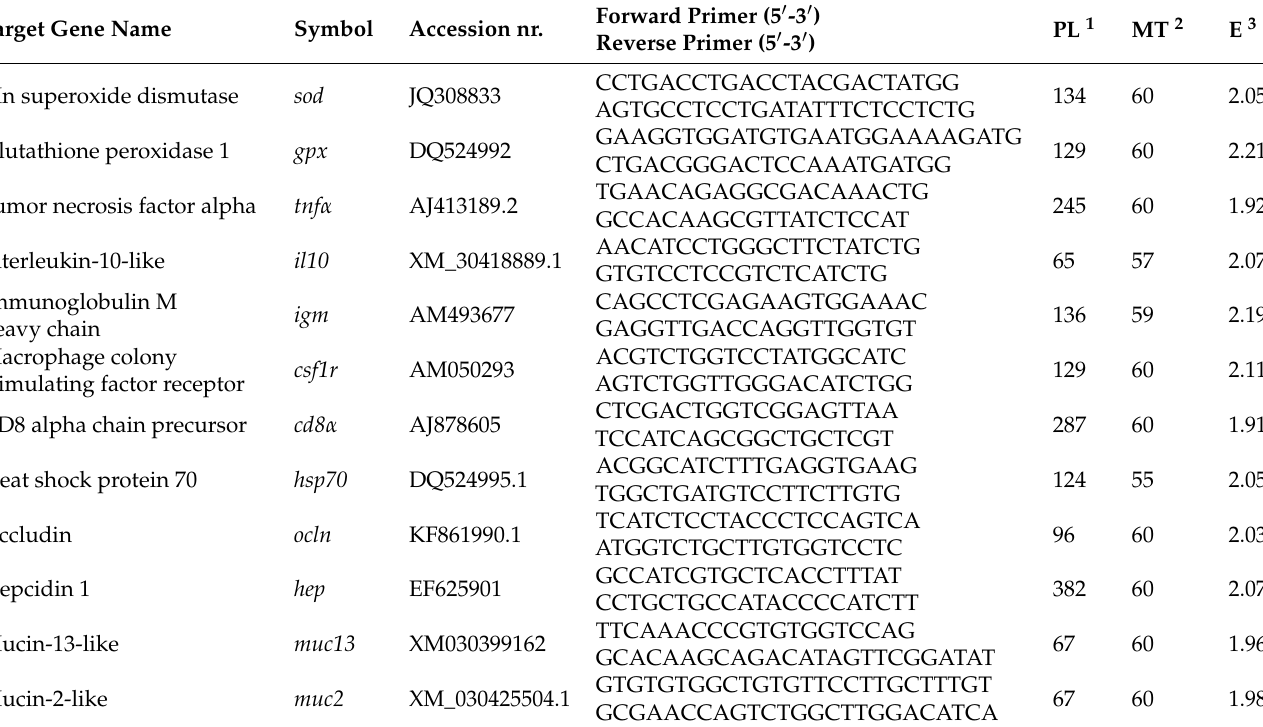
Table 2. Oligonucleotide primers information used for real-time PCR analysis of gene